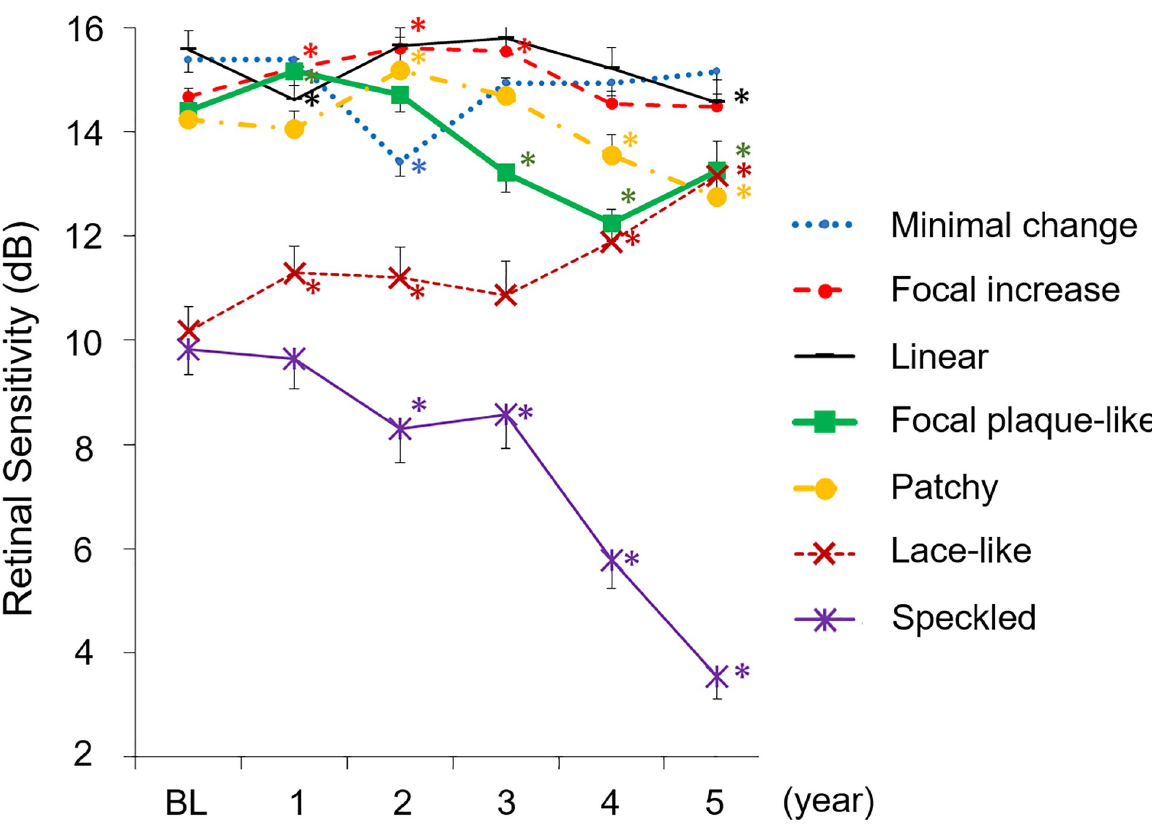
Fig 2. Transition of mean retinal sensitivity by each pattern of abnormal FAF during the 5 years. The number of each pattern differs at each time-point compared to baseline (cf. Fig 1). The sensitivity of the linear, focal plaque-like, patchy, and speckled FAF pattern decreased significantly compared to the baseline at the 5th year. The speckled FAF pattern at the 5th year had the lowest mean retinal sensitivity. The sensitivity of lace- like increased significantly compared to baseline at the 5th year. Data are expressed as mean ± standard error (SE). � P < 0.05 compared to baseline, paired t-test. BL: